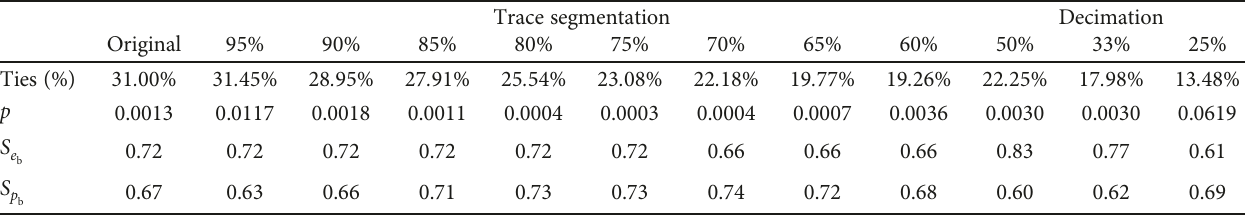
Table 2: Standard PE analysis using CGM records and downsampling (nonuniform, trace segmentation and uniform, and decimation), to lower the percentage of ties in patterns, with n = 4 .